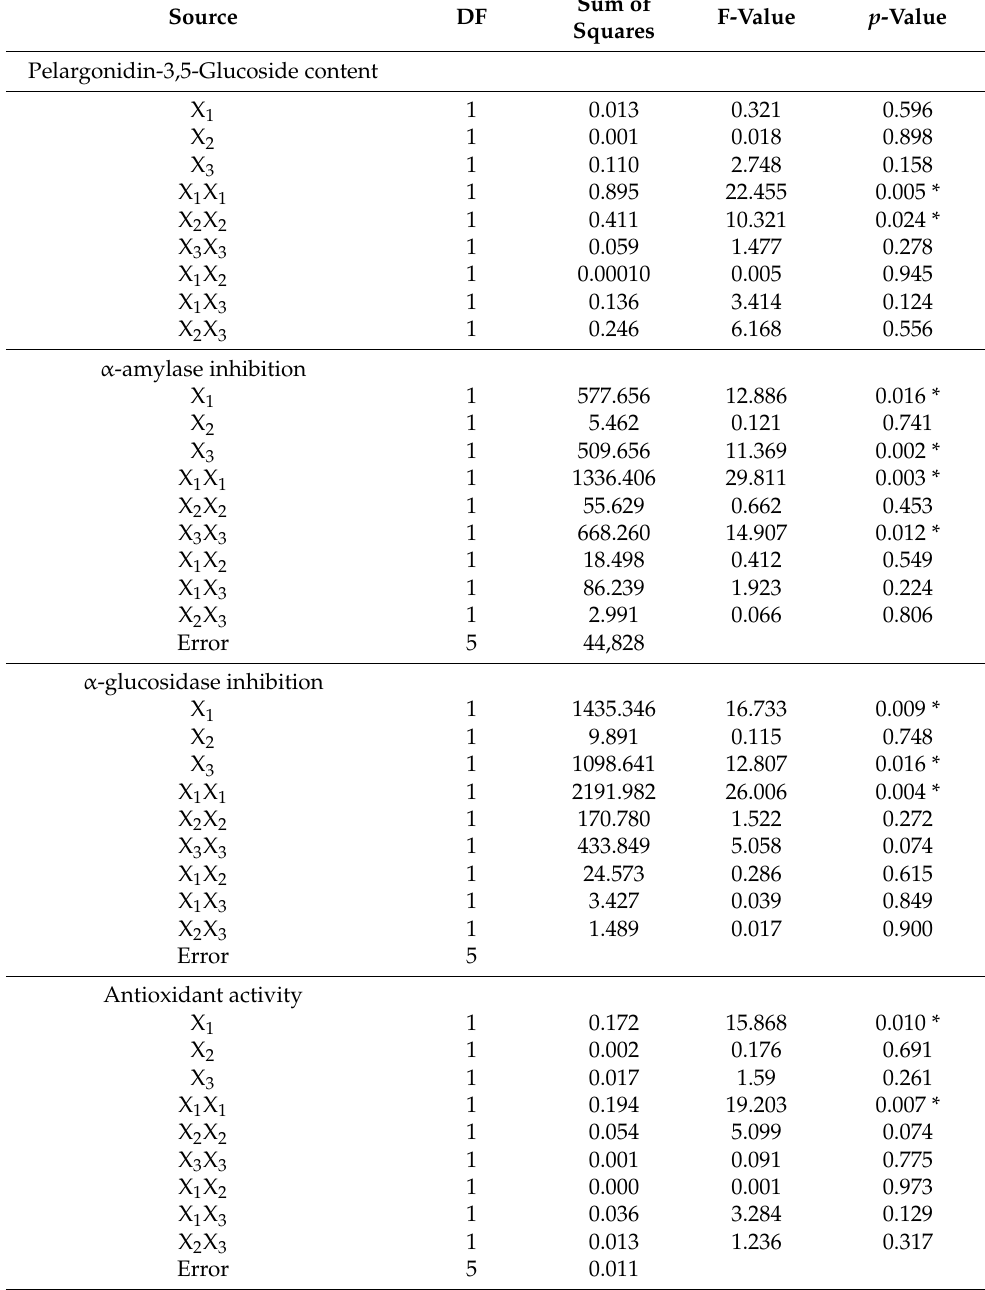
Table 1. The effect of linear, quadratic or interaction coefficients on the